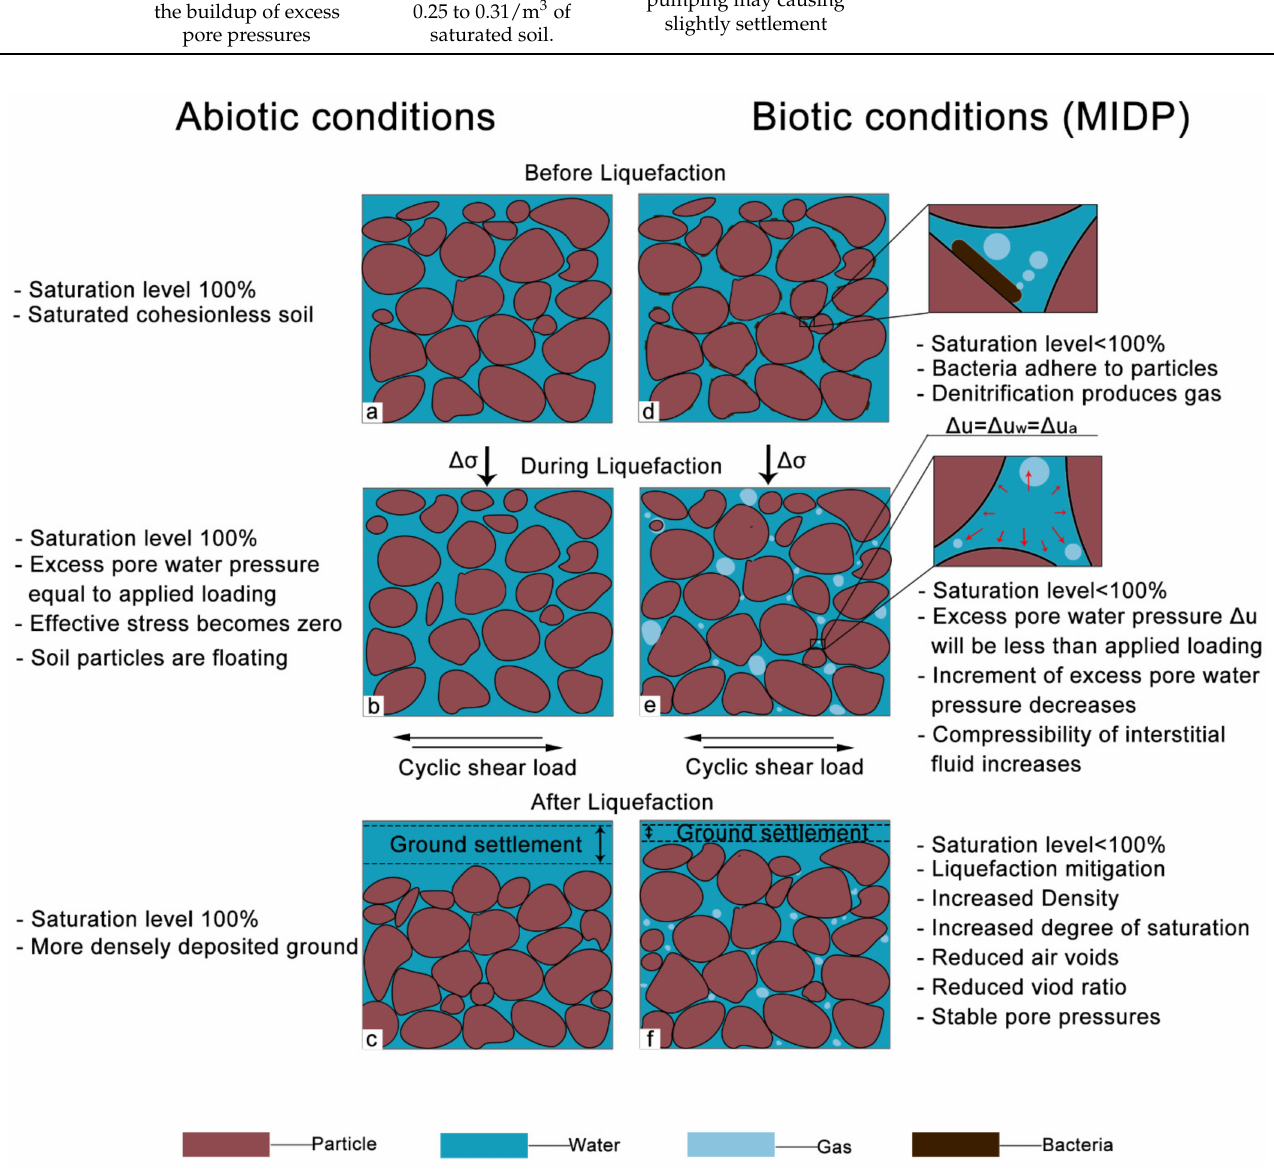
Figure 5. Schematic representation of the comparison between the liquefaction behavior of untreated saturated soil ( a – c ) and upon denitrification based MIDP ( d – f ), ( a ) fully saturated soil; ( b ) liquefaction of fully saturated soil after cyclic loading; ( c ) ground settlement due to liquefaction; ( d ) production of gas bubbles through microbial denitrification upon bioaugmentation or biostimulation of soil; ( e ) the decrease in excess pore water pressure of gas entrapped soils during cyclic loading; ( f ) ground settlement of partially saturated soil after cyclic